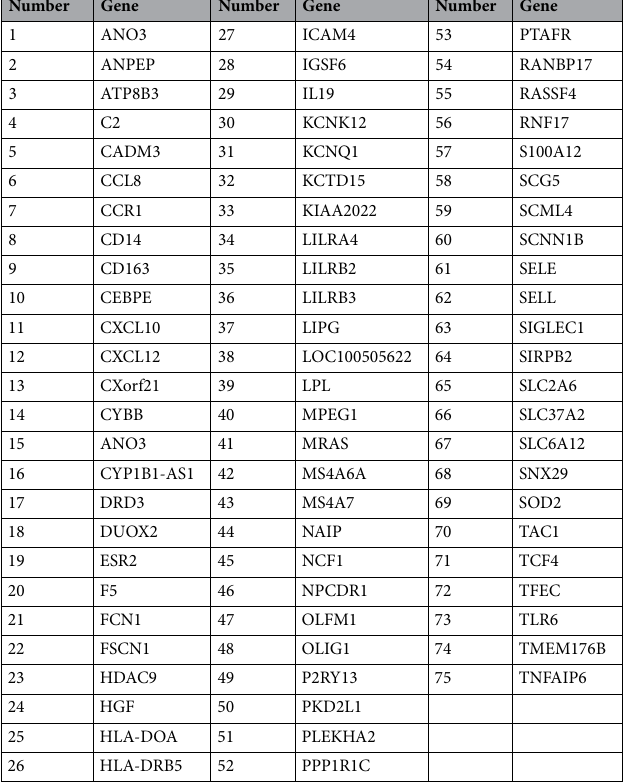
Table 5. Common gene of CG and OP.